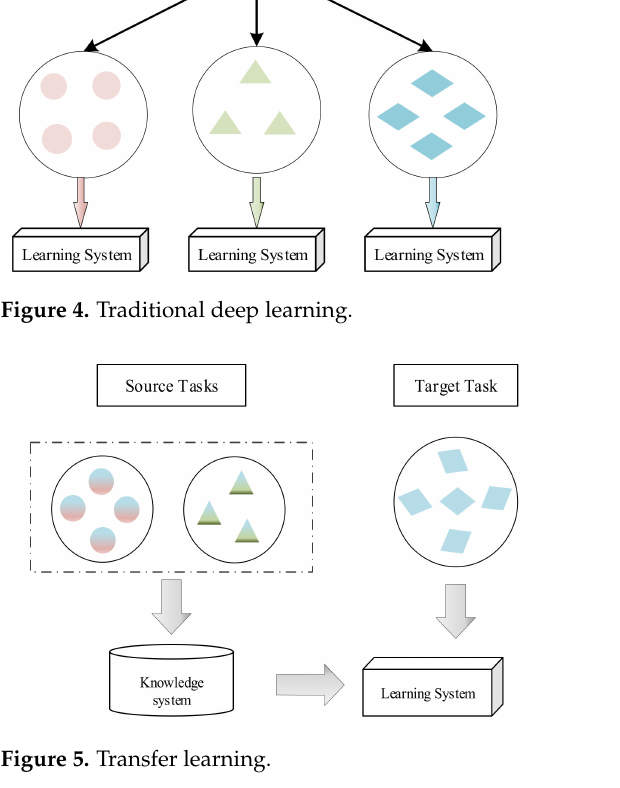
Figure 5. Transfer